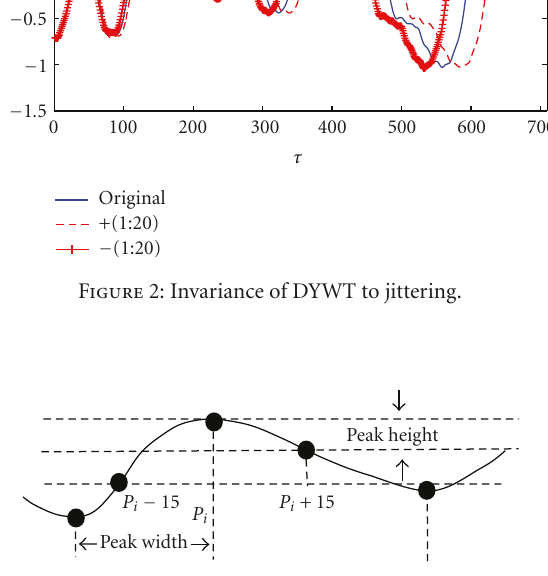
Figure 3: Peak width and peak